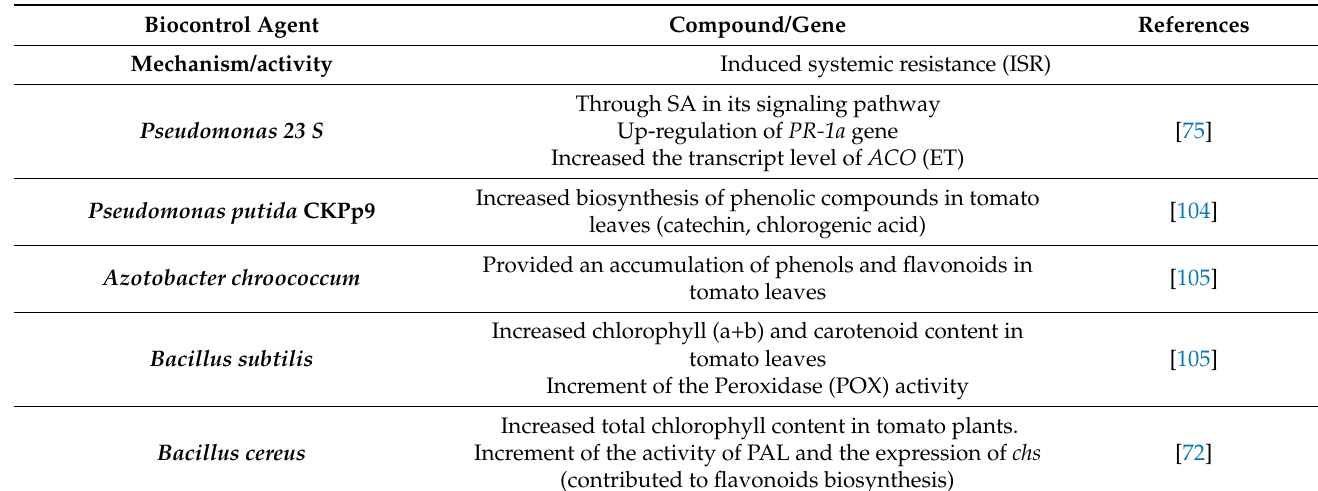
Table 3. Mechanisms for stimulating induced systemic resistance (ISR) by biocontrol